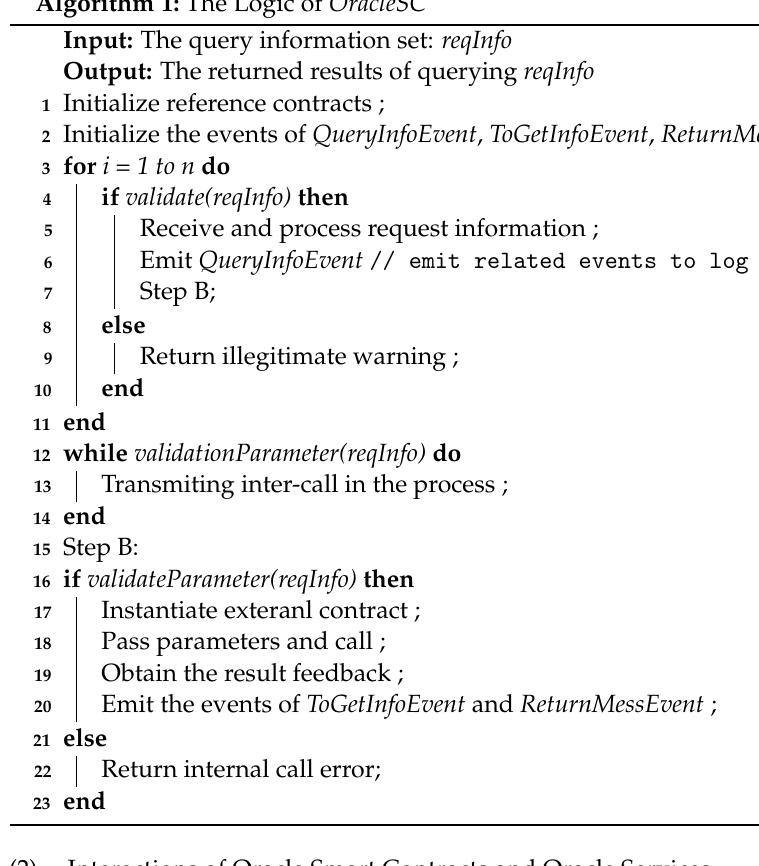
Algorithm 1: The Logic of